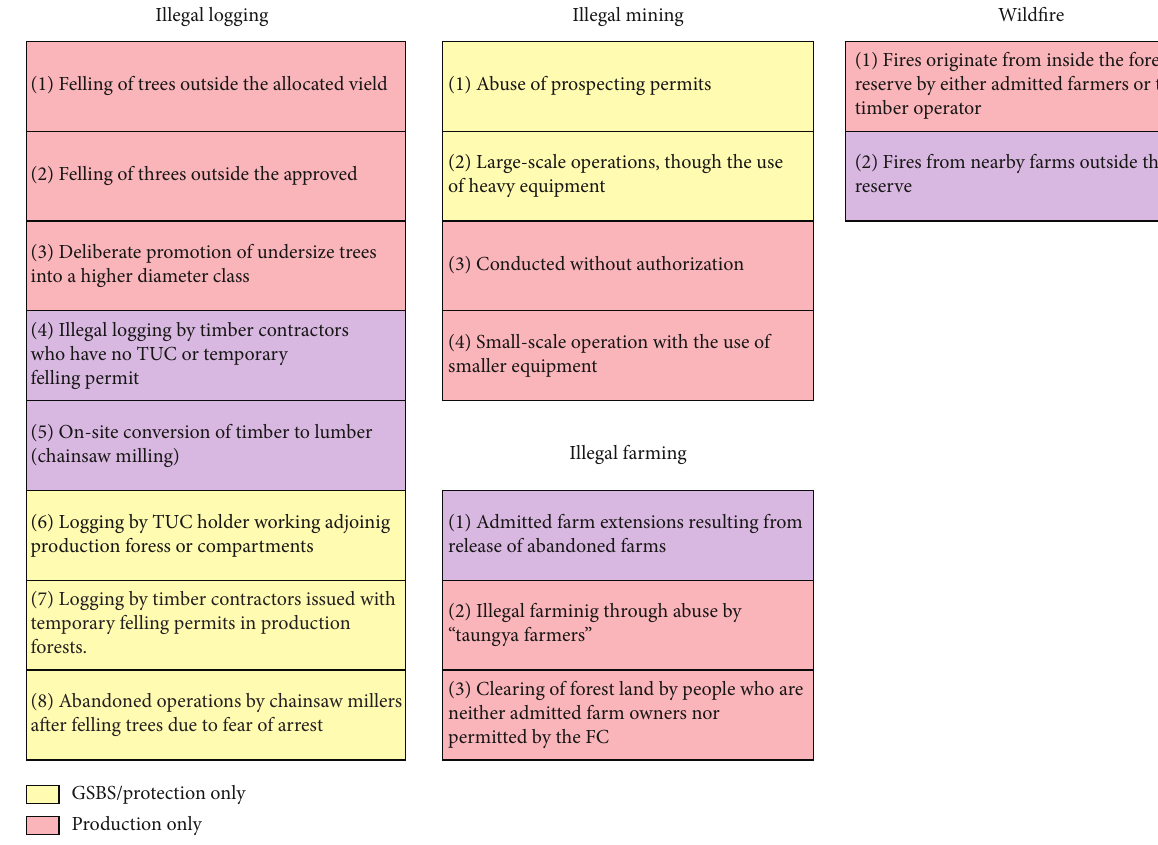
Figure 3: Manifestation of drivers in various management